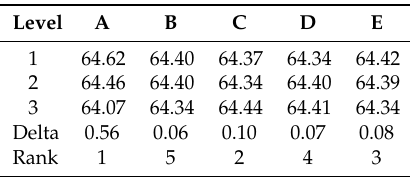
Table 5. Response table for the S/N ratios